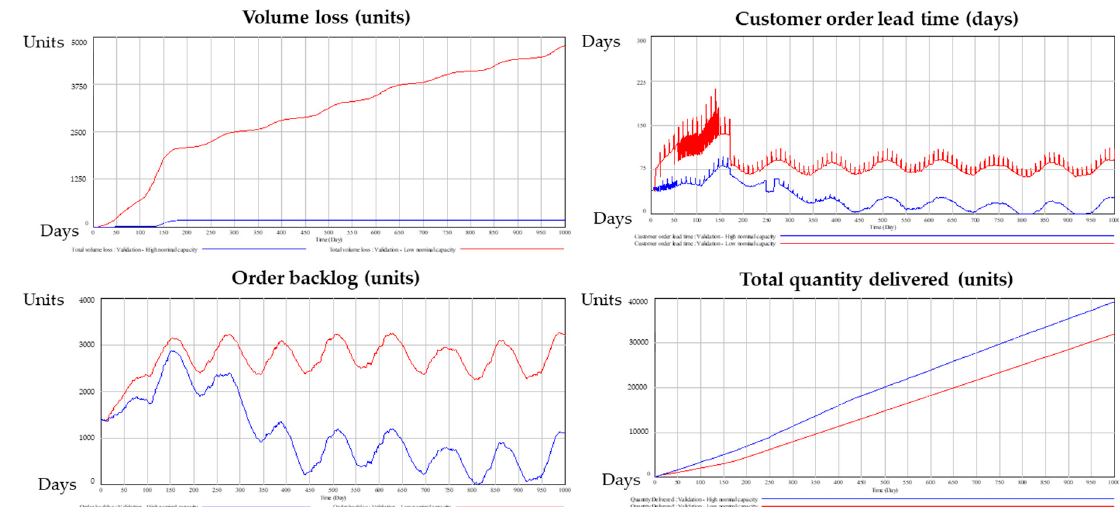
Figure 15. Results of the validation for nominal capacity using the extreme-value test (own elaboration). Legend: red lines for lower nominal capacity; blue lines for higher nominal capacity.